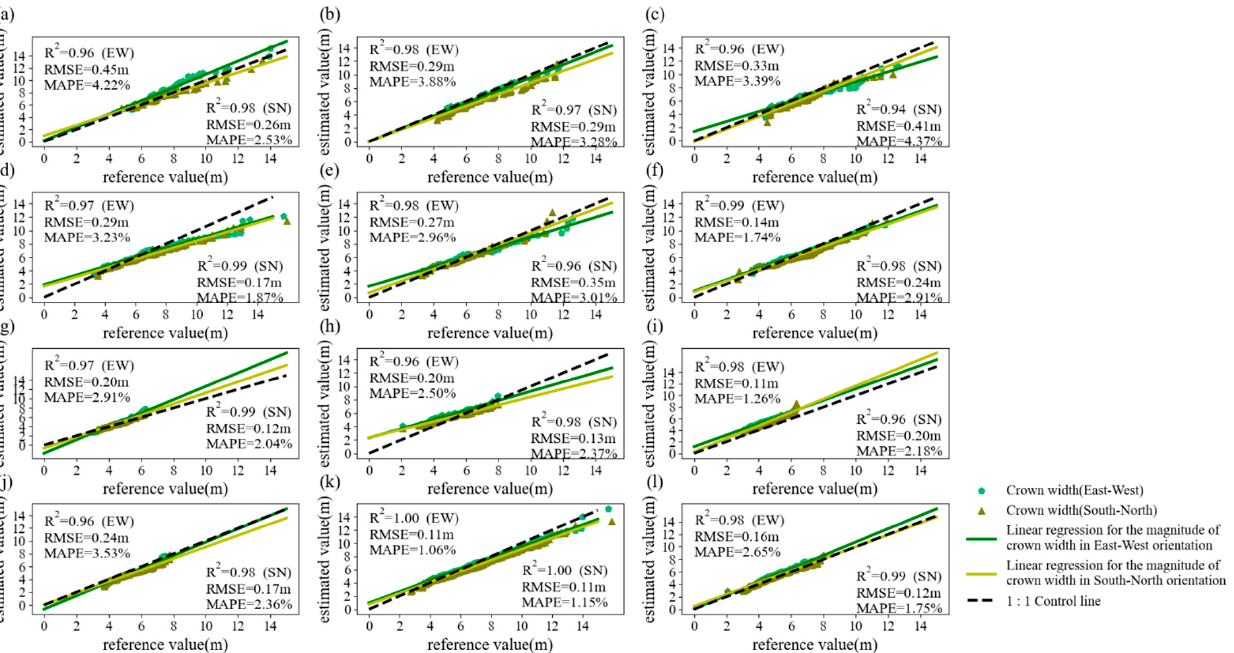
Figure 12. ( a – f ) Linear regression results of crown width measurements versus estimates obtained by algorithmic segmentation for the six sample plots from Plot_d1 to Plot_d6, ( g – j ) Linear regression results of crown width measurements versus estimates obtained by algorithmic segmentation for the four sample plots from Plot_s1 to Plot_s4, where R 2 (R Squared), RMSE (Root Mean Square Error) and MAPE (Mean Absolute Percentage Error) were used to evaluate the regression accuracy; ( k ) Linear regression results of all crown width measurements and estimates obtained by algorithmic segmentation for the six sample plots; ( l ) Linear regression results of all crown width measurements and estimates obtained by algorithmic segmentation for the four sample plots.